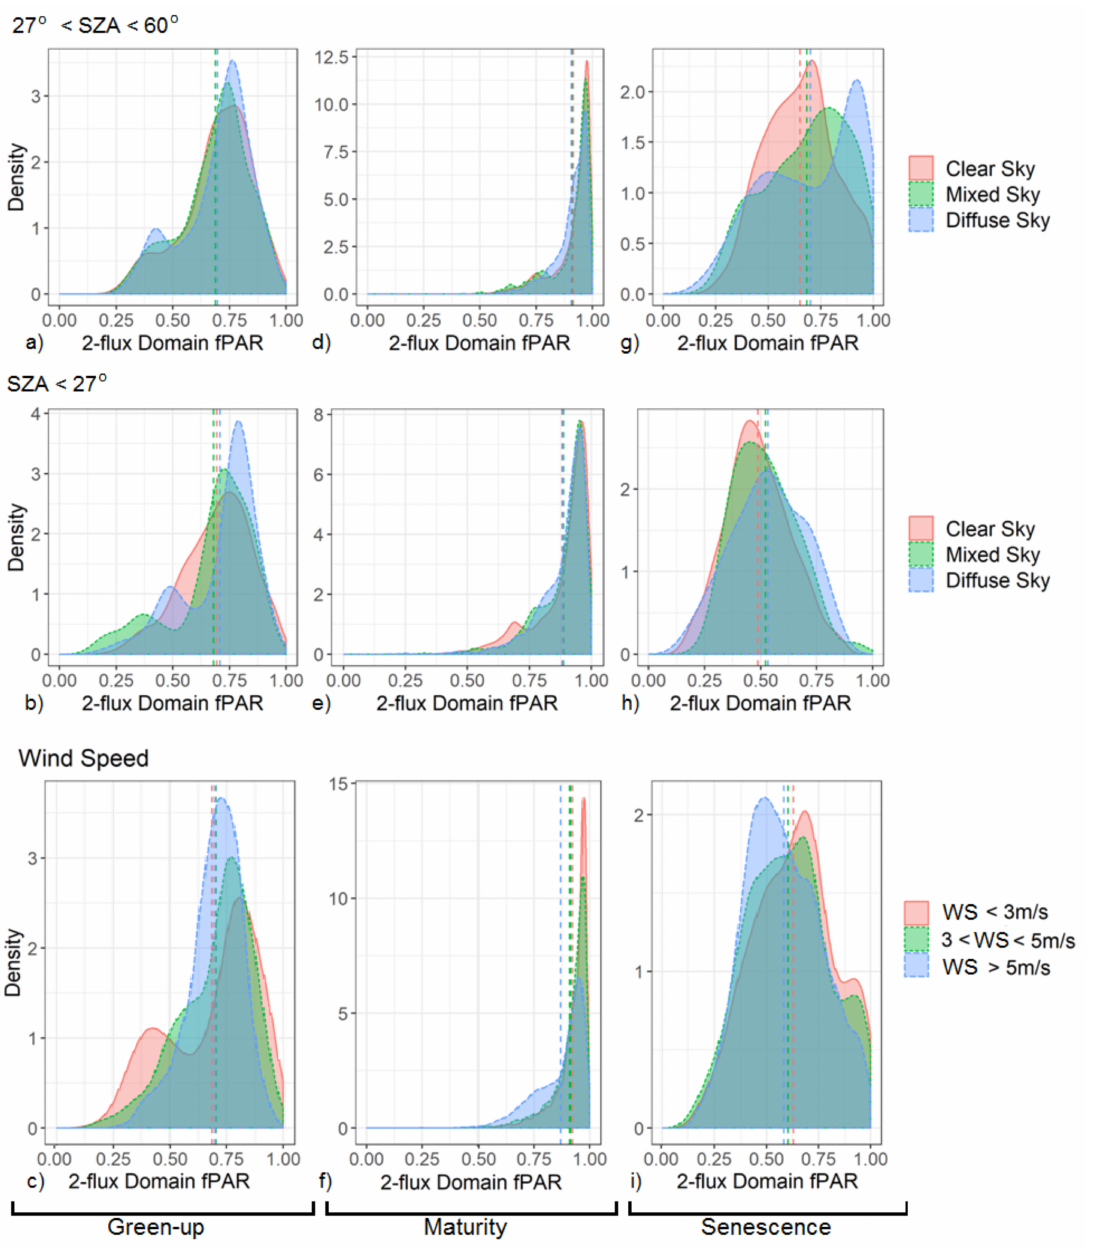
Figure 6. The influence of solar zenith angles, sky conditions, and wind speed on the distribution of 2-flux domain fPAR. These three sets of panels are split into the respective phenophases: ( a , b ), and ( c ) green-up; ( d – f ) maturity; ( g – i ) senescence. The upper and middle panels assess the fPAR distributions based on different SZA and sky conditions. The lower panel assesses the distribution of fPAR based on different wind